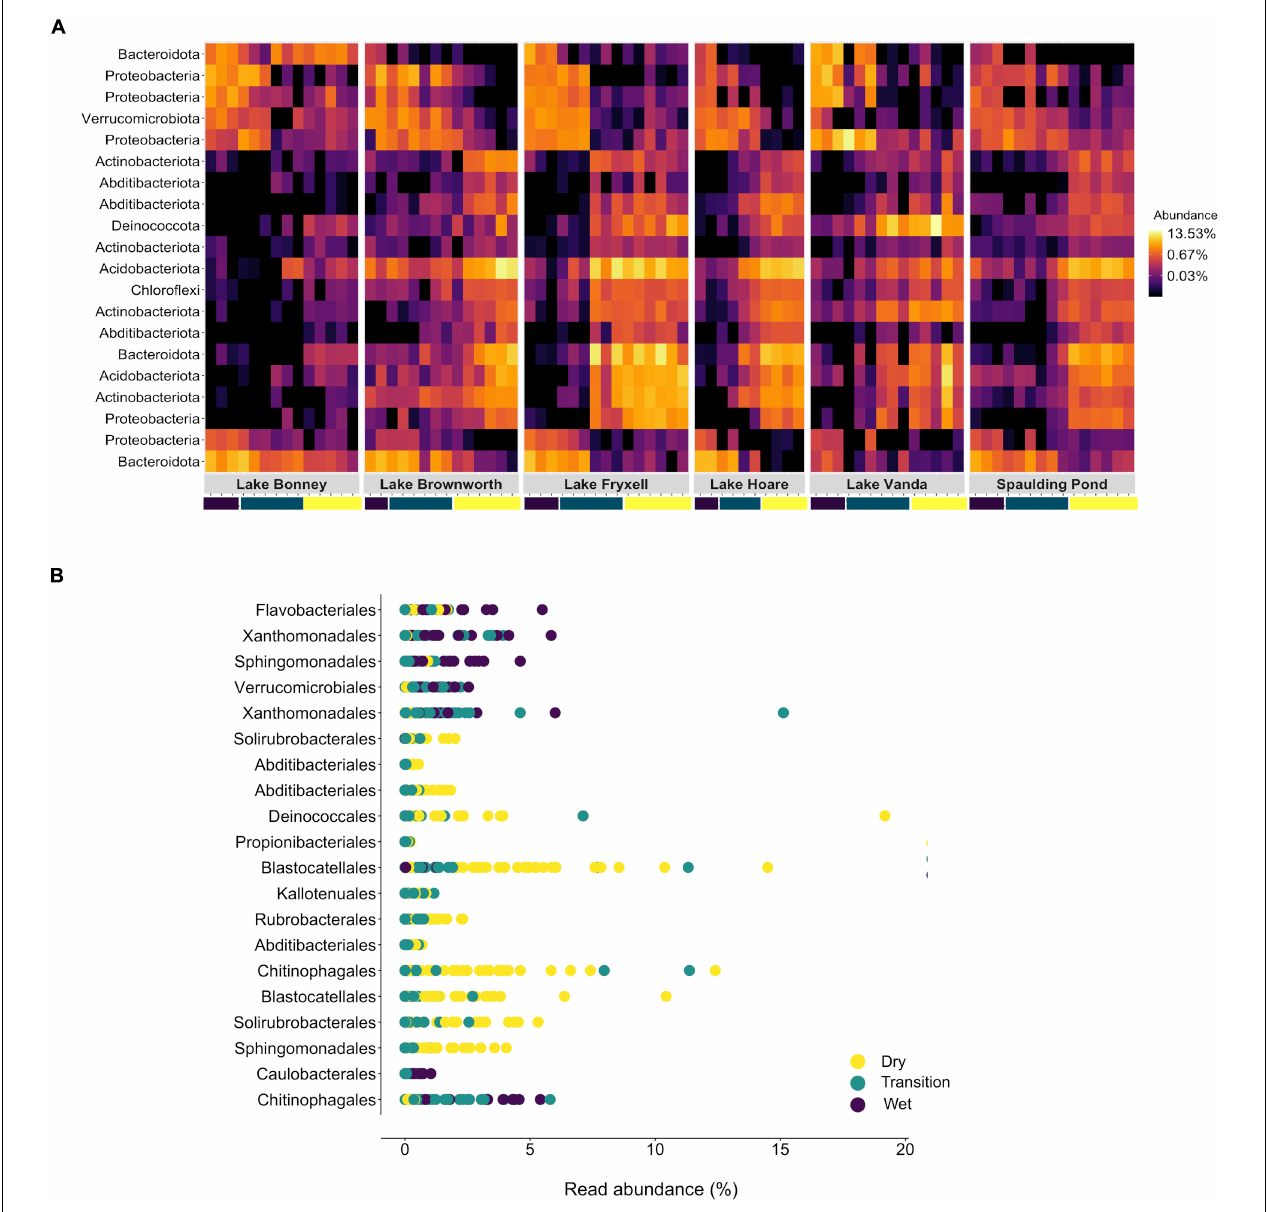
FIGURE 7 | (A) Heatmap of the top 20 bacterial OTUs classified by Random Forest classification analysis as the most important to discriminate between the different zones of lake transects. Each row represents each OTU at the phylum level, and the colour of the box indicates the relative abundance of each OTU, with yellow depicting high relative abundance and black low relative abundance. (B) Rank abundance plot of the correspondent top 20 OTUs identified across the different zones of the SFT transects at the order